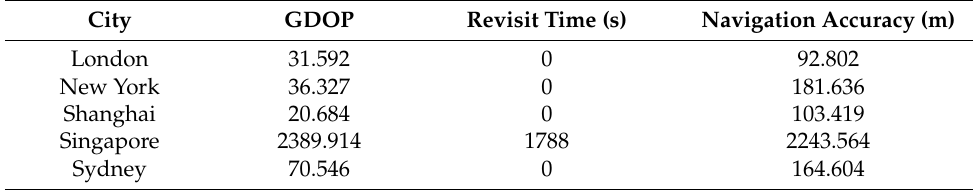
Table 4. Table of Iridium constellation coverage performance of five smart cities.